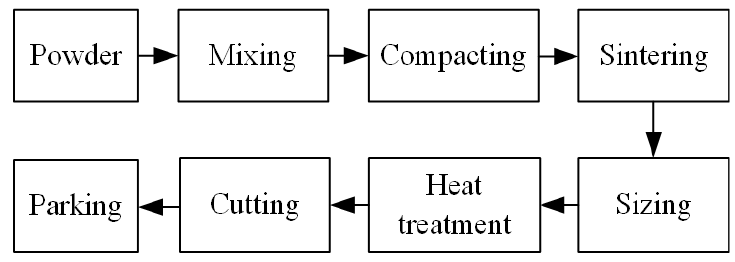
Figure 2. The manufacturing process of the test sample.